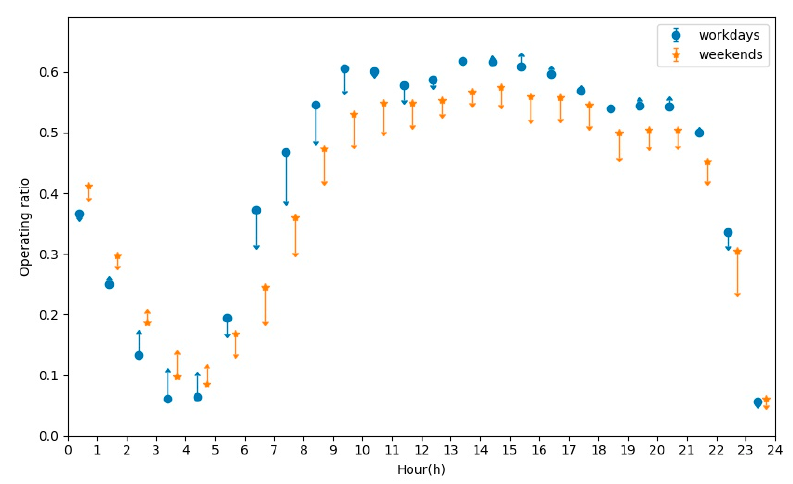
Figure 13. The taxi operating ratio.